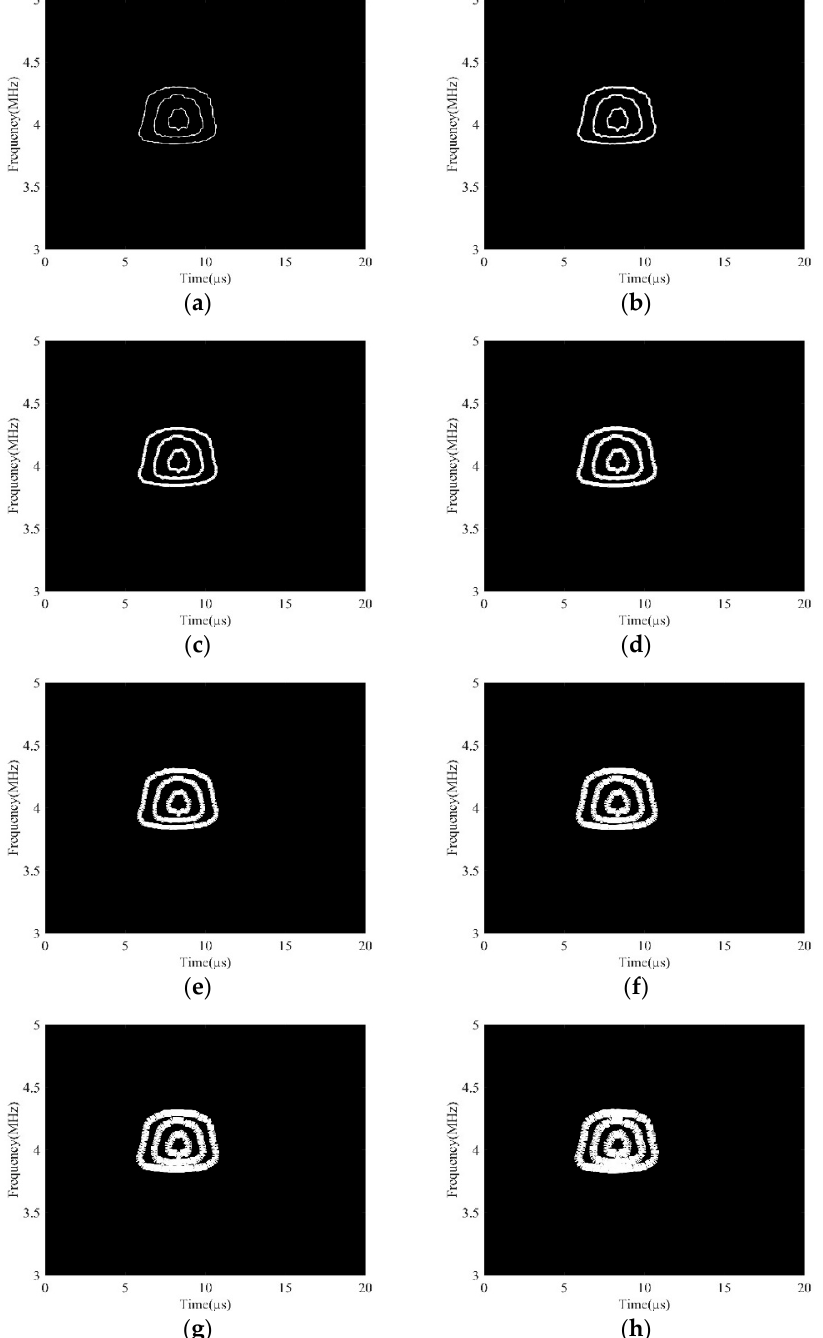
Figure 6. DWFP images of different white slice ratios. ( a ) 0.1; ( b ) 0.2; ( c ) 0.3; ( d ) 0.4; ( e ) 0.5; ( f ) 0.6; ( g ) 0.7; ( h ) 0.8.